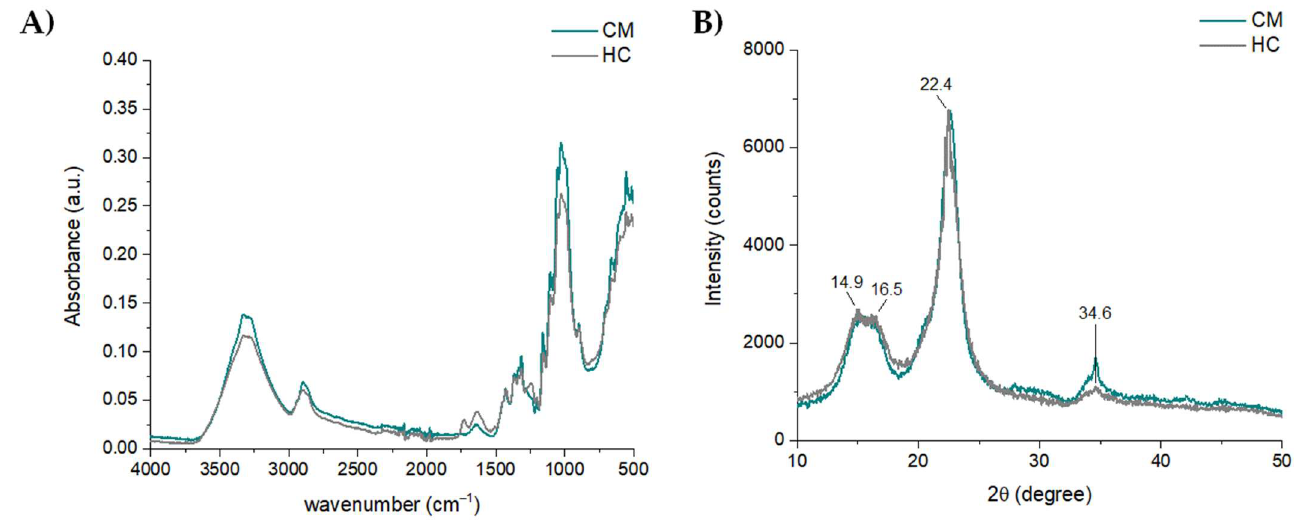
Figure 4. ( A ) ATR-FTIR spectra and ( B ) XDR patterns of HC sample and microcrystalline cellulose (CM) standard. Spectra were processed using OriginPro 2015 software.